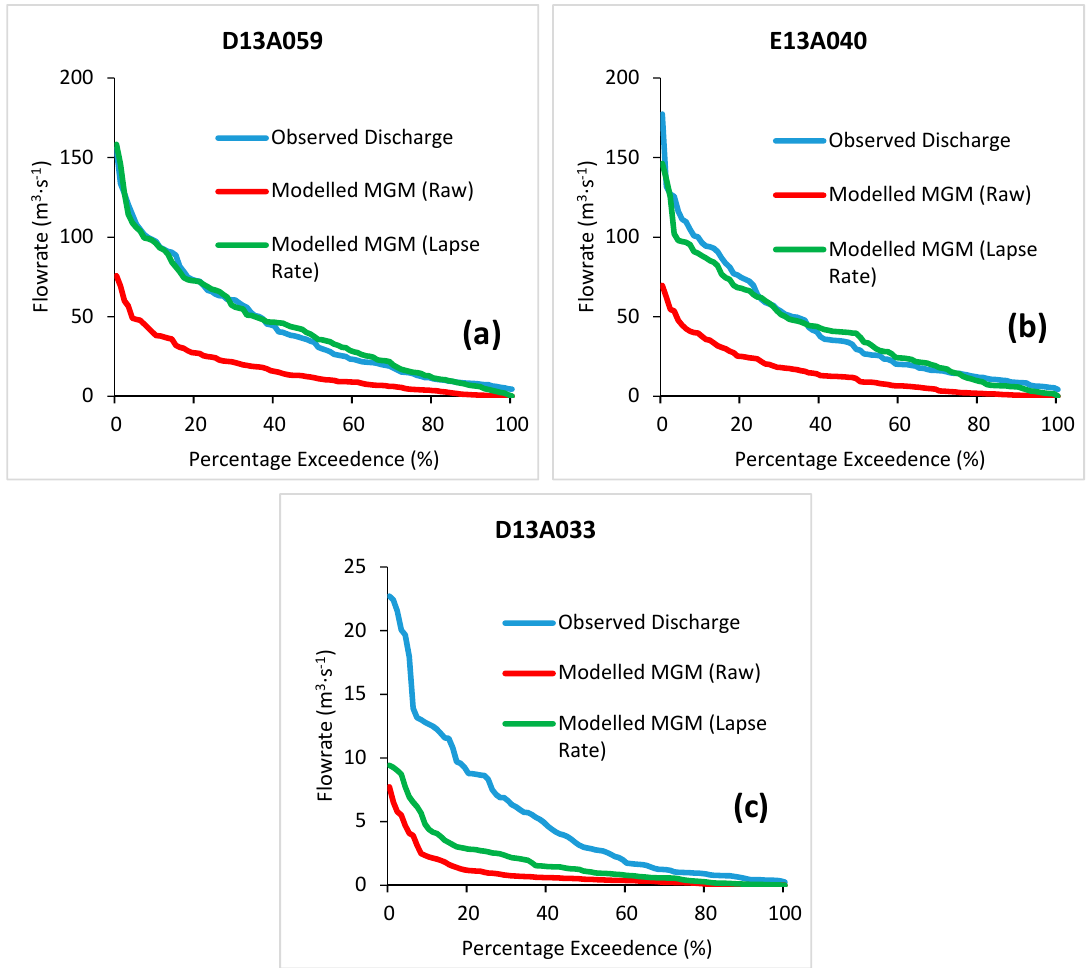
Figure 9. Flow duration curves (FDC) of default simulation results after application of elevation band to the local climate data. ( a ) Gauge station no D13A059, ( b ) Gauge station no E13A040, ( c ) Gauge station no D13A033.